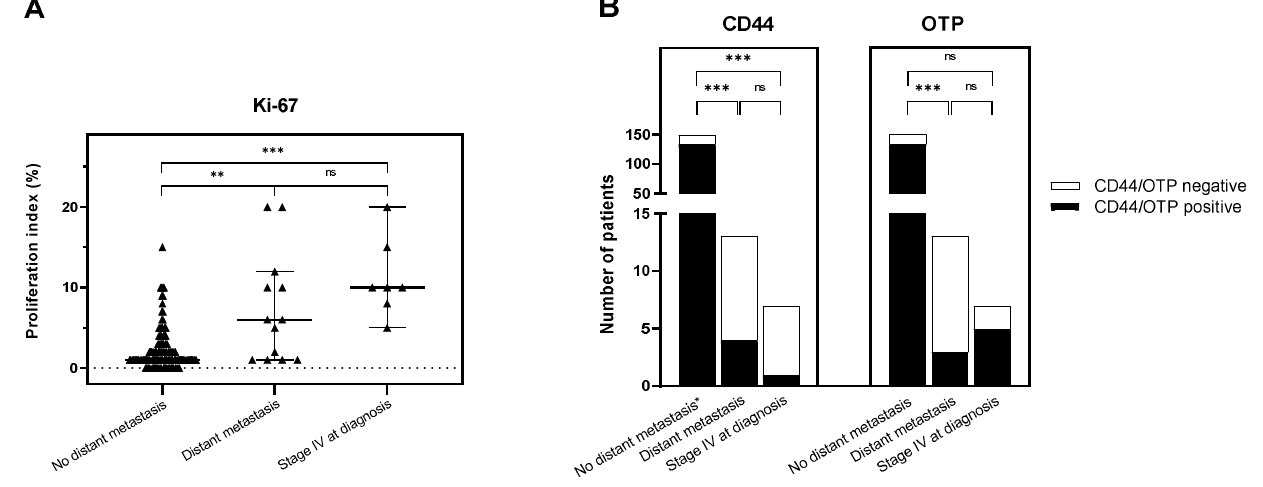
Figure 2. Immunohistochemical analysis of Ki-67 ( A ), and CD44 and OTP ( B ) expression in the studied patient categories; significance was determined using the Mann-Whitney U test ( A ) and Chi-Squared or Fisher’s Exact test ( B ); ns = not significant; ** p < 0.01; *** p < 0.001. ns: p > 0.05.